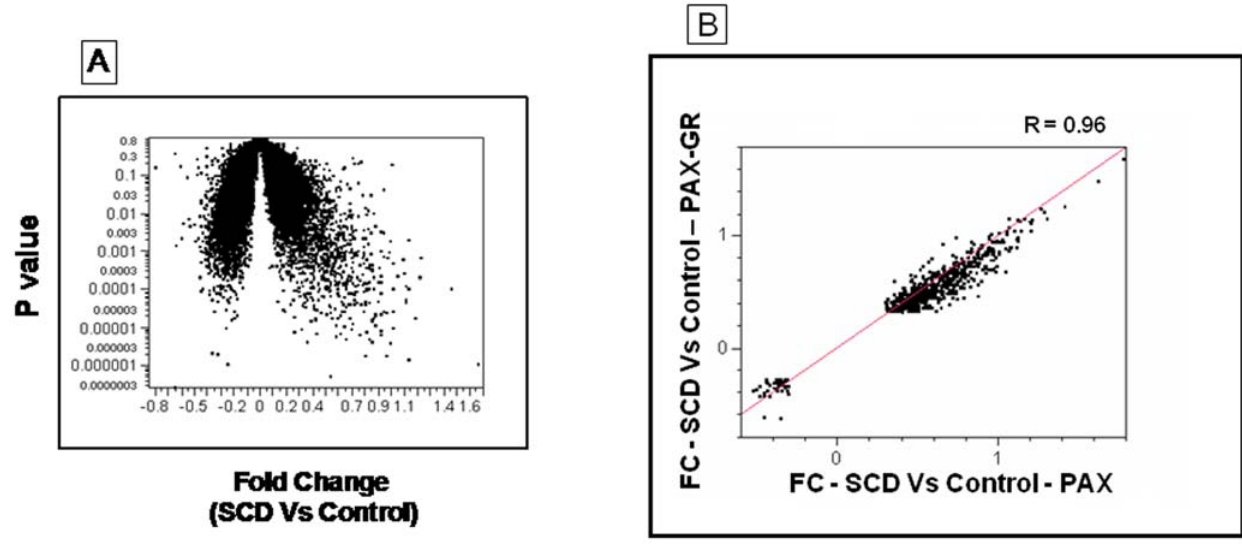
Figure 6. A – Volcano-plot of the comparison between SCD and control samples. The X axis represents the fold change and the Y axis represents the P value. B – Correlation of differentially expressed genes in PAX and PAX-GR